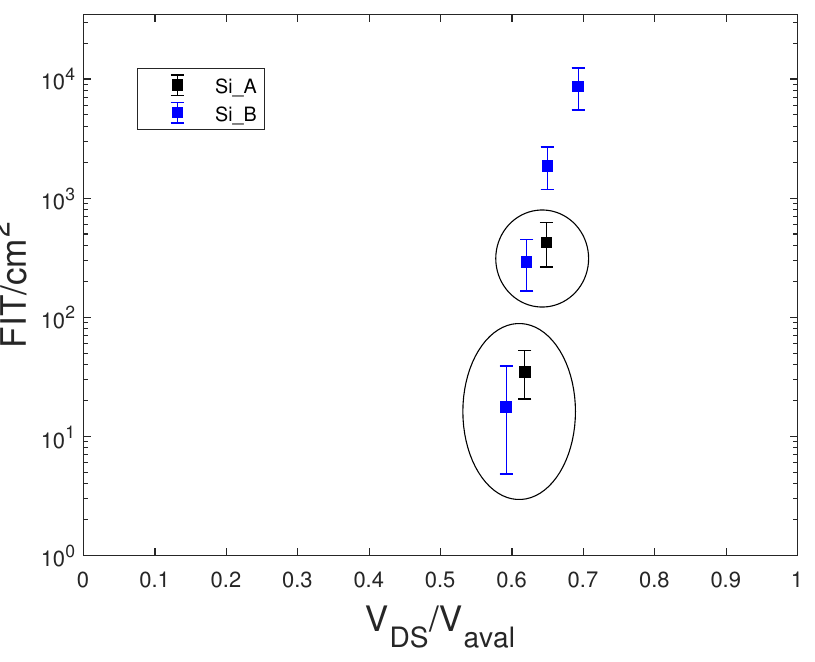
Figure 10. Measured FIT/cm 2 versus V DS / V aval of equal Si MOSFETs with different chip